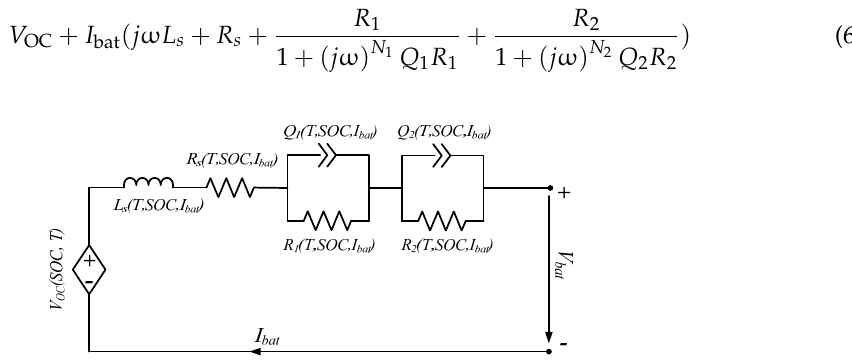
Figure 15. Basic electrical configuration of the performance model of the LFP/C battery.